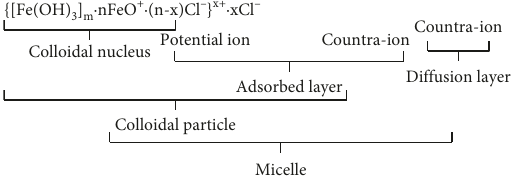
Figure 6: Structure formula of micelle.